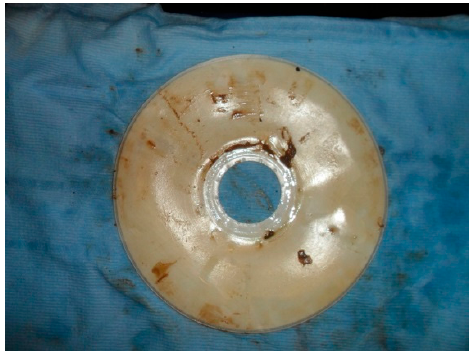
Figure 13. Impact of fouling on the rotating MBR system—even caking is observed.